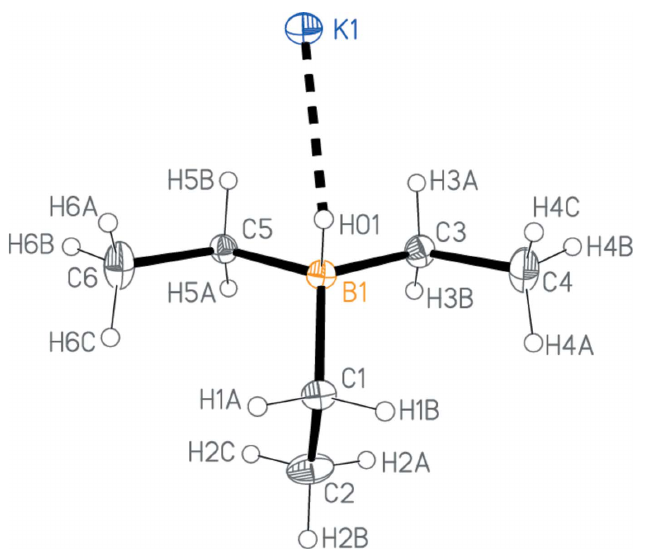
Figure 3 Simplified packing diagram of KHBEt 3 viewed parallel to the b axis. Hydrogen atoms except for H01 are